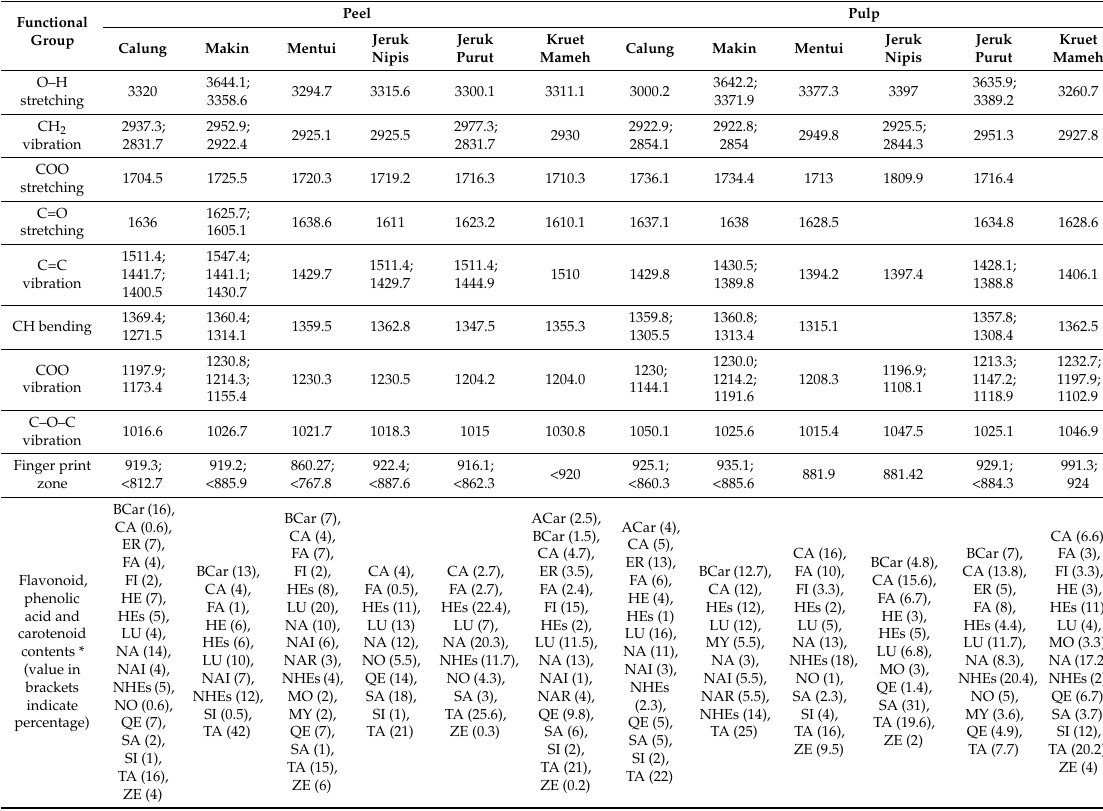
Table 2. Infrared bands in the spectral region of 3500–500 cm − 1 of various citrus extracts and the fitting results to the reference flavonoids, phenolic acids and